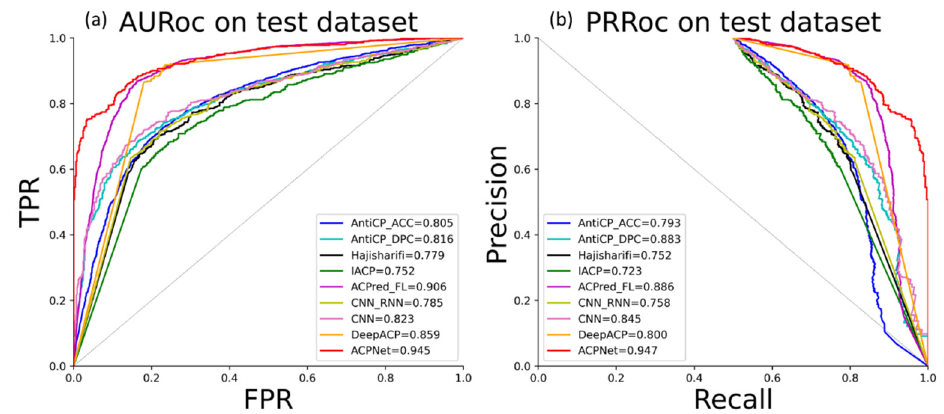
Figure 5. AURoc ( a ) and PRRoc ( b ) on test dataset.